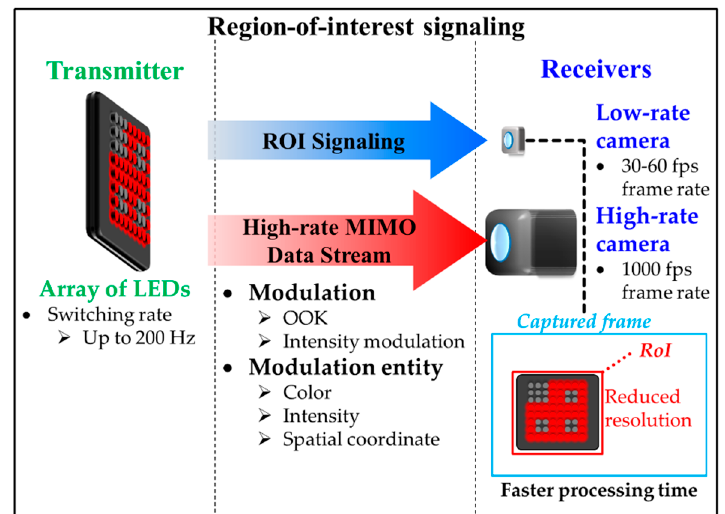
Figure 17. Region-of-interest signaling.